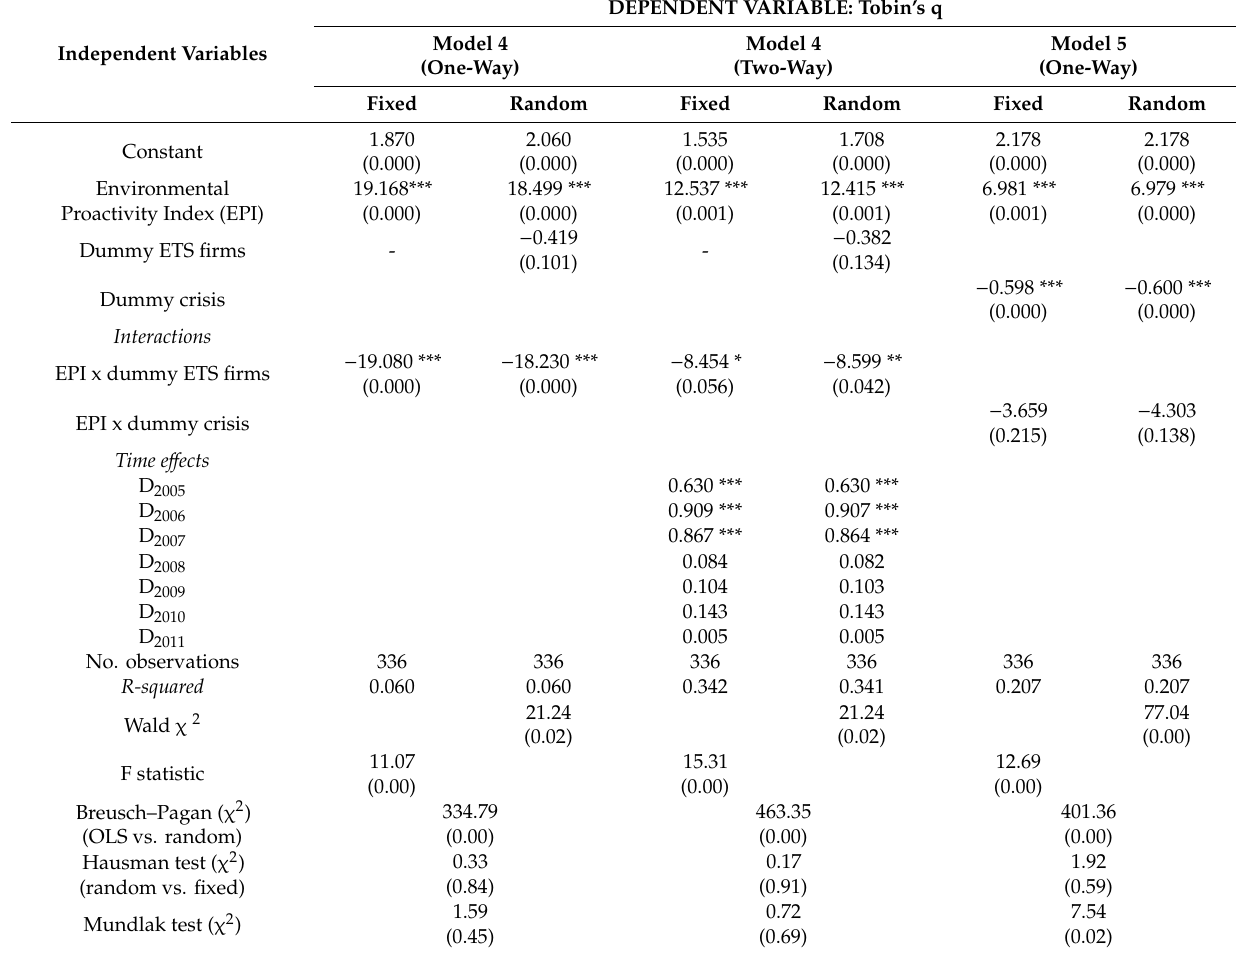
Table 4. Panel estimation. Hypotheses 2 and